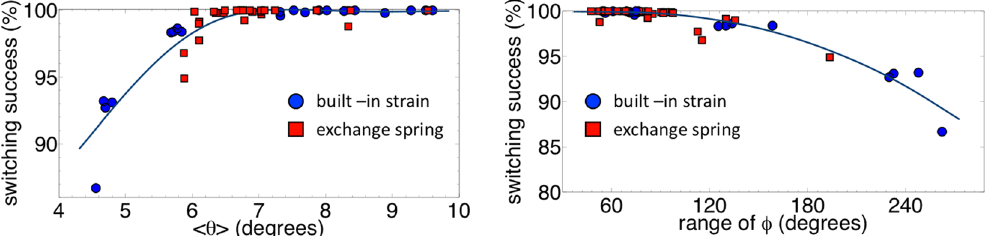
Figure 7. Dependence of the switching success on the detected amplitude ( θ ) and phase ( φ ) of the spin wave, combining results from both the approached. A high switching success and error-free logic functionality can be ensured if the amplitude of the detected spin wave ( < θ > ) remains higher than a threshold value of around 6° and the detected phase falls within the window of 280° through 0 to 20° or 100° to 200° with a maximum allowable φ range of around